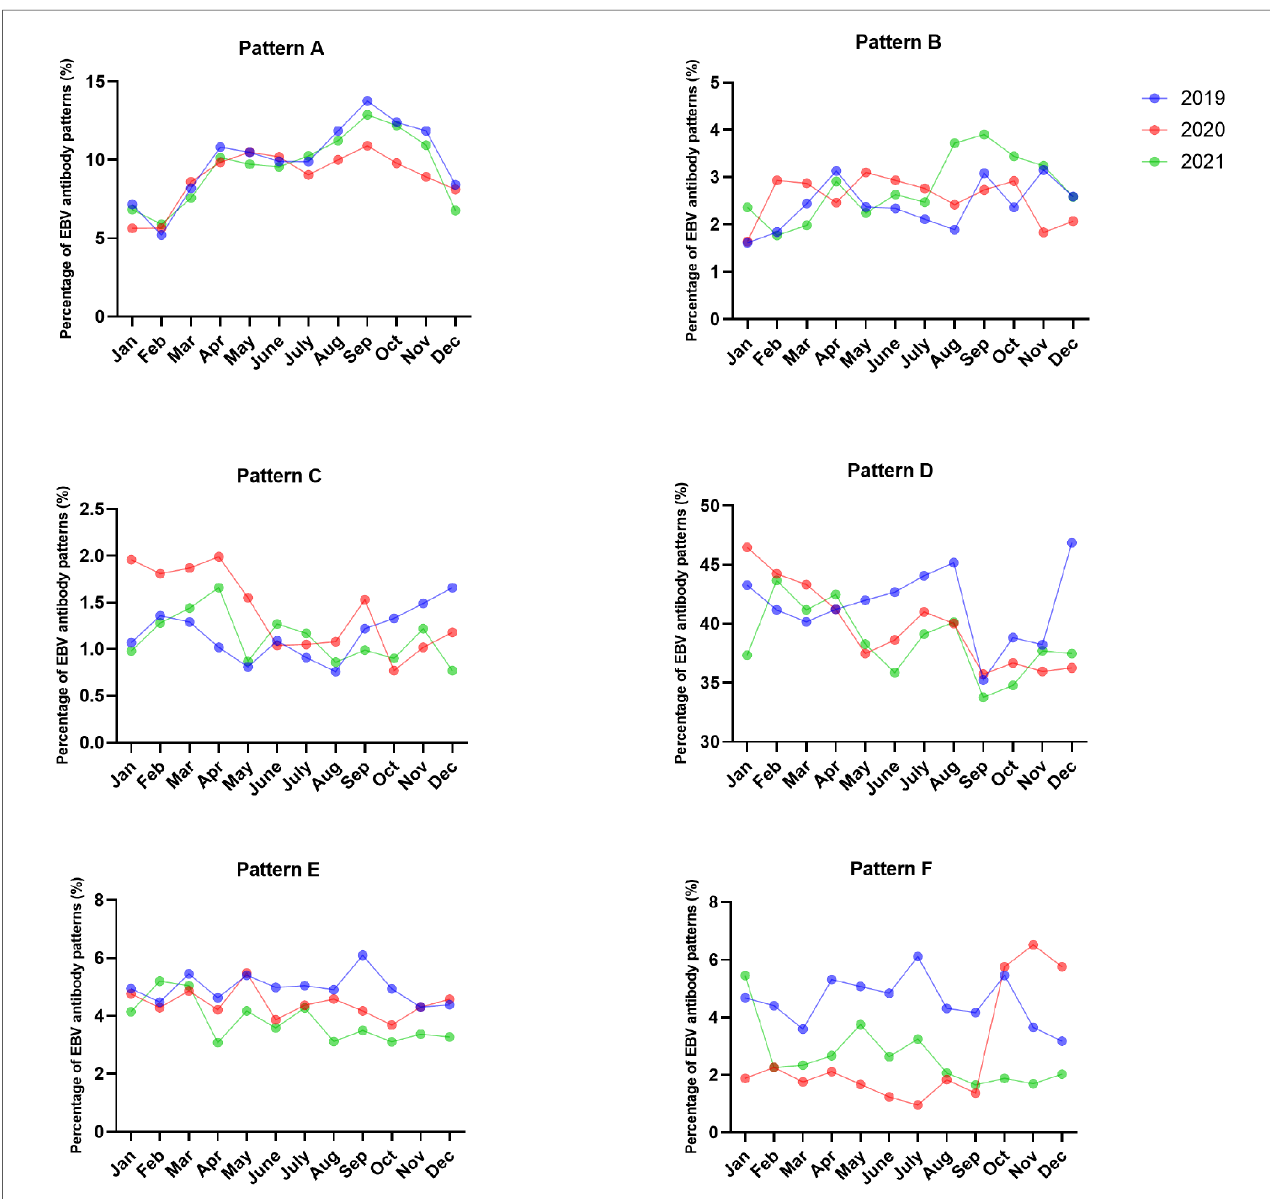
FIGURE 3 The percentages of EBV antibody patterns based on months between January 2019 and December